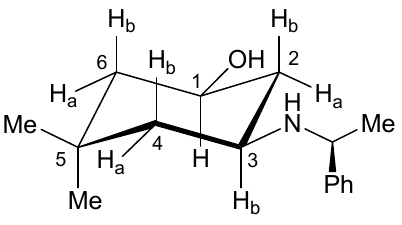
Figure 3. Conformation of the compound cis - 4